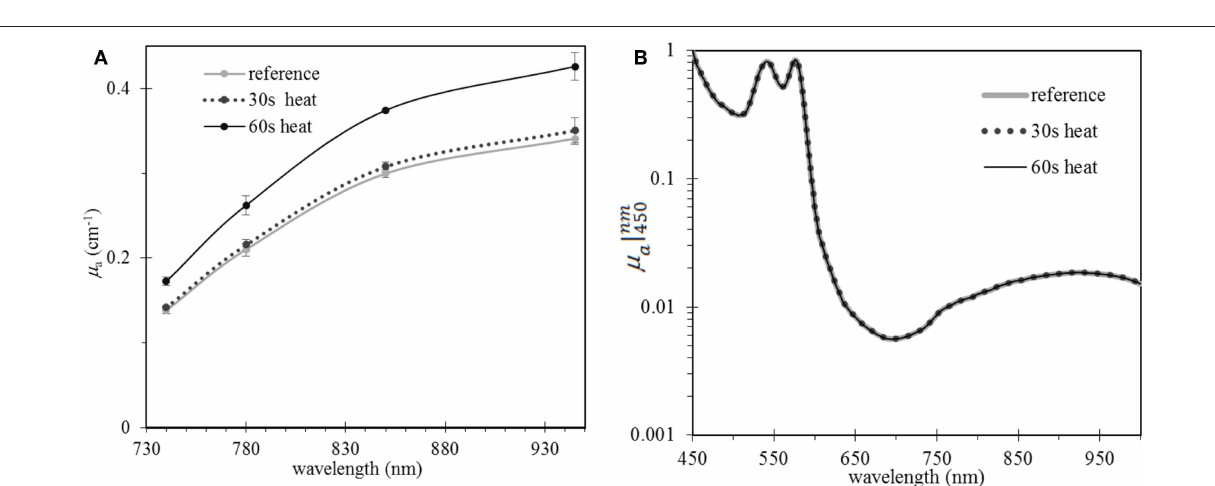
FIGURE 4 | Examples of heating can increase hemoglobin concentration but do not affect the shape of absorption spectrum: Effect of prolonged heating time up to 1min on (A) µ a values at four wavelengths, and (B) µ a spectral shape. Data from phantom Ctrl.HbY0 was presented. Heating temperature is kept at 65 ◦ C degrees. The “reference” curve represents a liquid phantom that was not